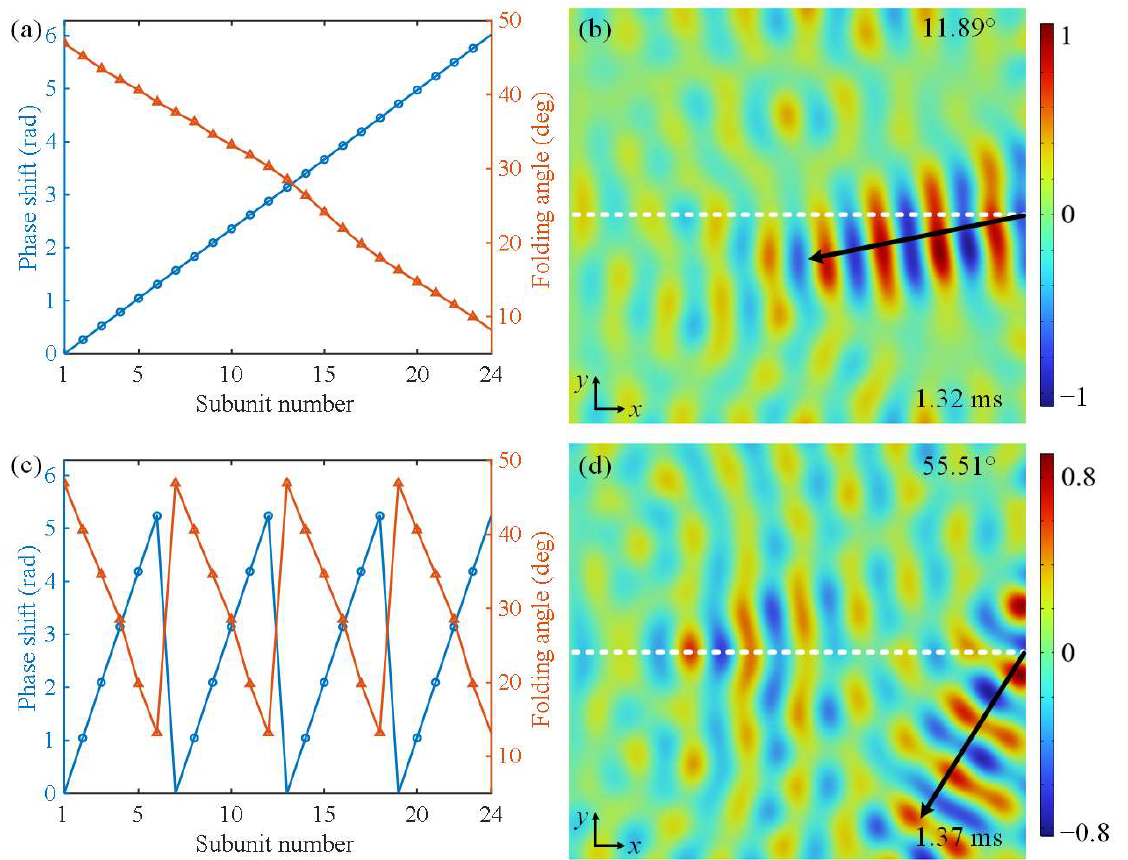
Figure 6. ( a ) Distribution of the phase shift obtained from the GSL and the distribution of the folding angle obtained from the numerical simulations in the metasurface and ( b ) numerical simulation results of the reflected flexural wave field when n is 24 at 8000 Hz. ( c ) Distribution of the phase shift obtained from the GSL and the distribution of the folding angle obtained from the numerical simulations in the metasurface and ( d ) numerical simulation results of the reflected flexural wave field when n is 6 at 8000 Hz.